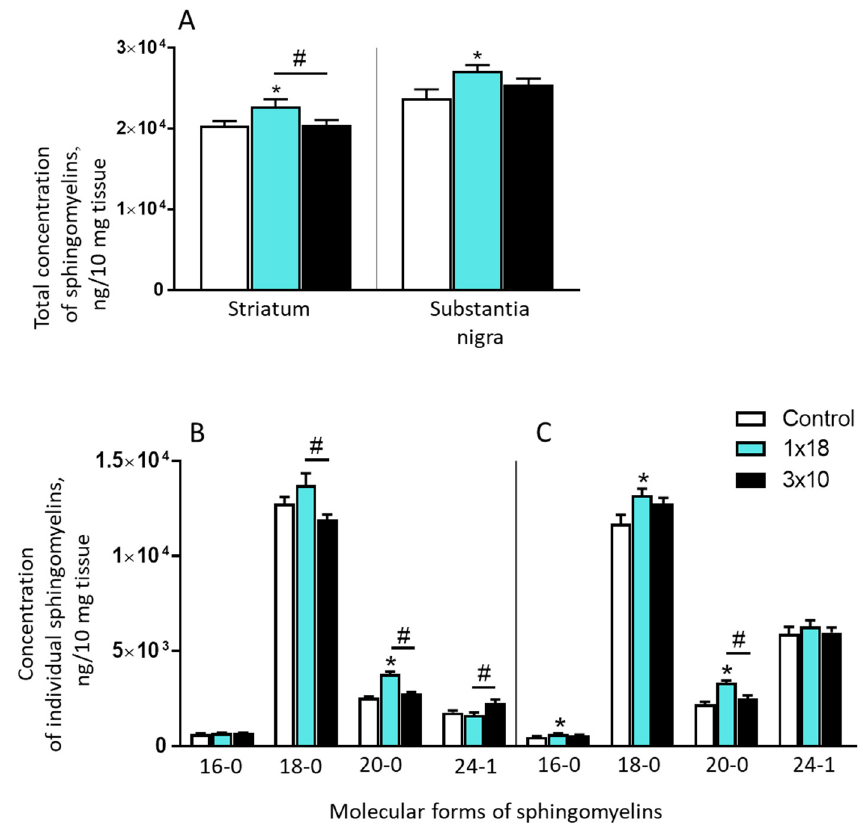
Figure 4. Total (cumulative) concentration of all measured sphingomyelins (14-0, 16-1, 16-0, 18-1, 18-0, 20-1, 20-0, 22-1, 22-0, 24-1, 24-0, and 26-1) in the striatum and substantia nigra ( A ) in mice 2 weeks after the administration of 1-methyl-4-phenyl-1,2,3,6-tetrahydropyridine (MPTP): once at a single dose of 18 mg/kg (1 × 18) and three times at a single dose of 10 mg/kg (3 × 10), as well as the concentration of individual sphingomyelins in the striatum ( B ) and in the substantia nigra ( C ) in the same experiments and in the controls (saline). * p < 0.05, significant differences compared to the controls; # p < 0.05, significant differences between the groups 1 × 18 and 3 × 10.